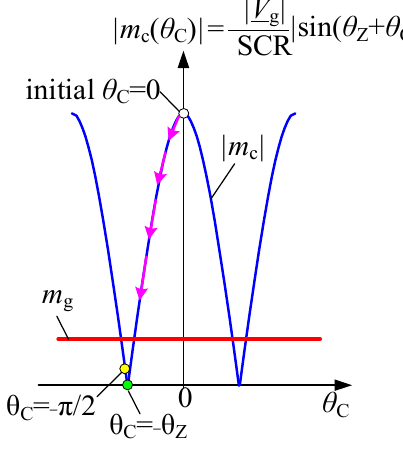
Figure 5. Trajectories of | m c ( θ C )|.